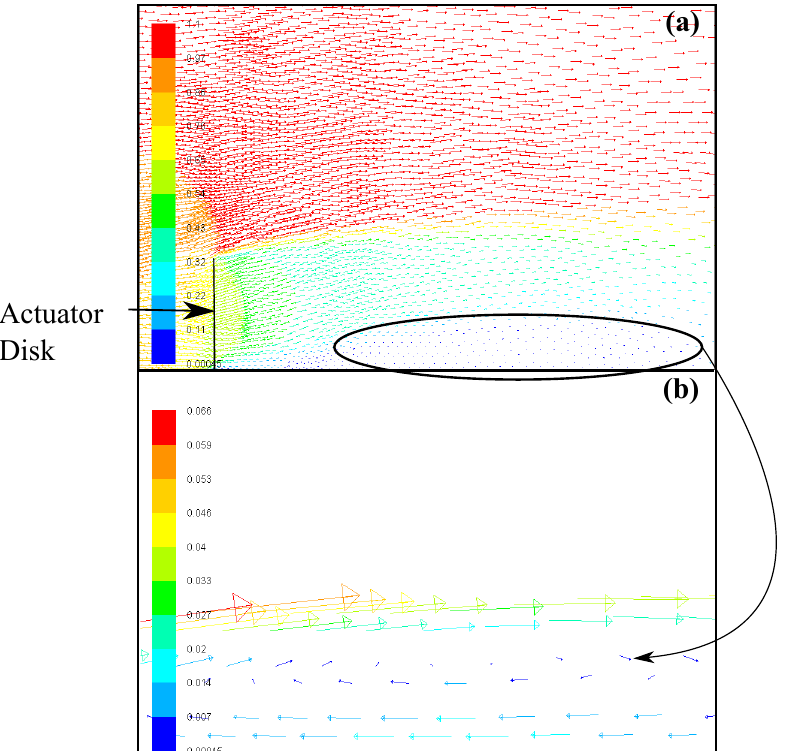
Figure 7. Axisymmetric flow pattern of an expanding wake behind the actuator disk for CT = 1.01, ( a ) general view of the flow on the actuator disk; ( b ) zoomed-up of the wake’s inner region revealing incipient